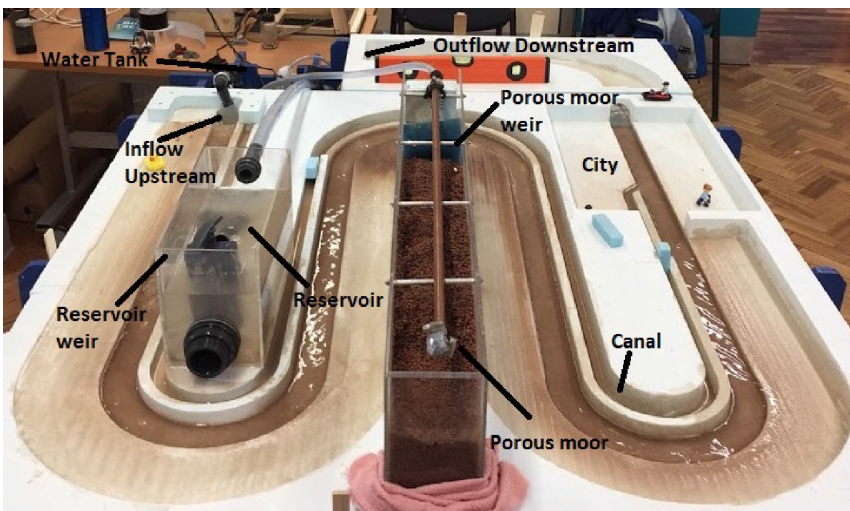
Figure 6. Overview of the Wetropolis Flood Demonstrator with its winding river channel of circa 5.2m and the slanted flood plains on one side of the river, a reservoir, the porous moor, the (constant) upstream inflow of water, the canal with weirs (the three small blue foam wedges seen in the photograph), the higher city plain, and the outflow in the water tank/bucket with its three pumps. Two of these pumps switch on randomly for (1, 2, 4) or 9s of each wd = 10s. Photo compilation: Luke